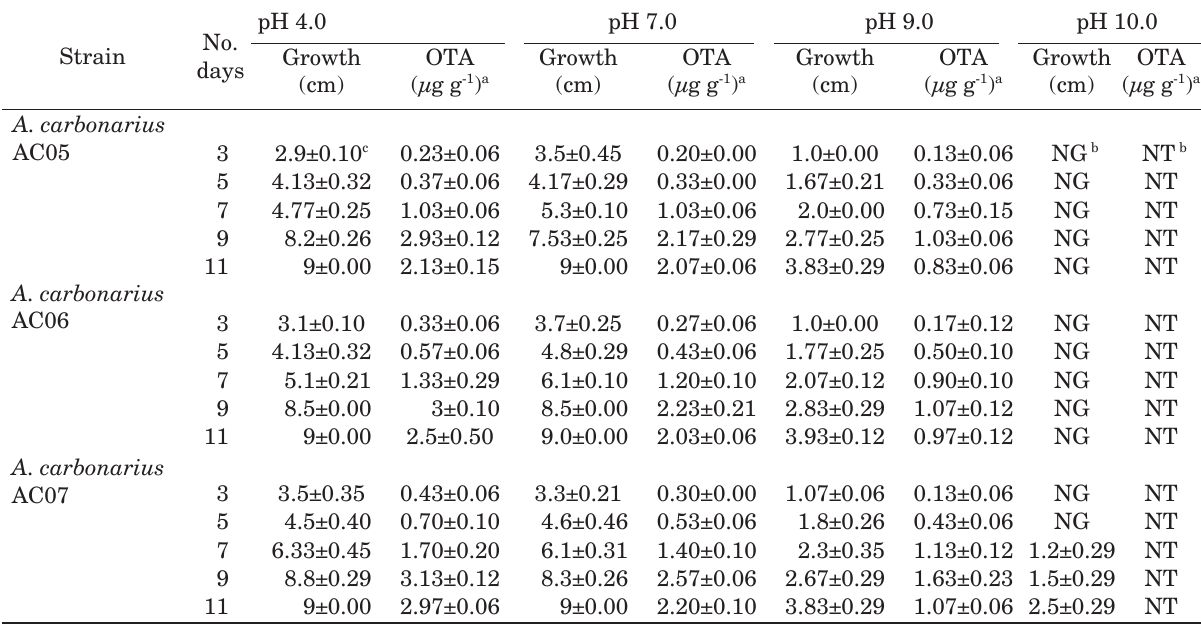
Table 3. Mycelial growth and production of OTA by three A. carbonarius strains on YES (yeast extract sucrose) agar at different pH